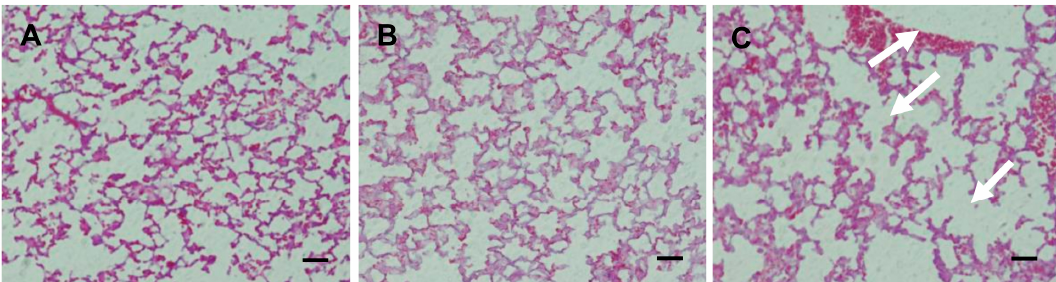
Figure 2. Lung sections from each administration method. Representative microscopic views of alveoli in ( A ) a non-saline-treated mouse, ( B ) a saline-treated mouse (negative pressure method), and ( C ) a saline-treated mouse (MicroSprayer ® ). After 1 min of saline administration, the lung was removed. Lung sections were stained with hematoxylin and eosin. The injuries that appeared are highlighted with white arrows. Scale bar = 40 μ m.